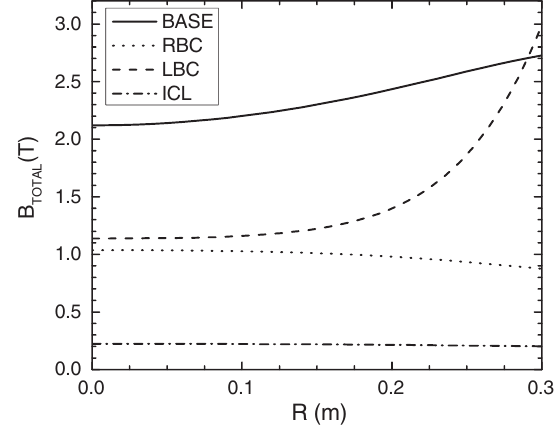
FIG. 6. Total magnetic field with respect to the radius, R , for the z position corresponding to the wall of the rf cavity.